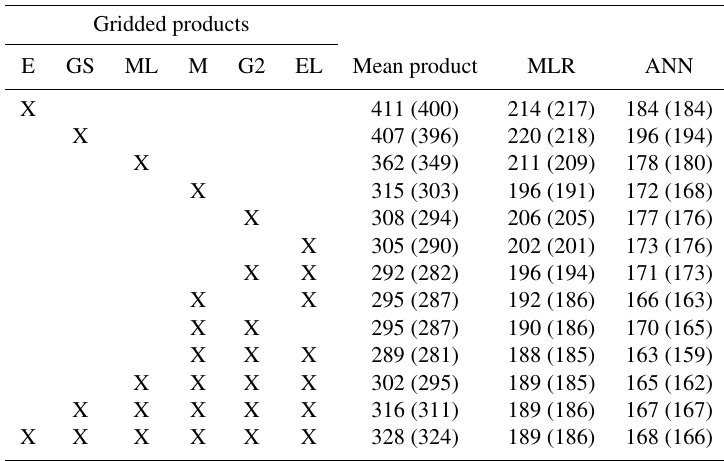
Table 1. Mean station MAEs (in mm SWE) for individual and combinations of products and corresponding MLR and ANN runs, with the mean station MAEs computed using only the VIC stations given in parenthesis. Products shown are ERA-Interim (E), GlobSnow (GS), MERRALand (ML), MERRA (M), GLDAS2 (G2), and ERALand (EL). Gridded products E GS ML G2 EL Mean